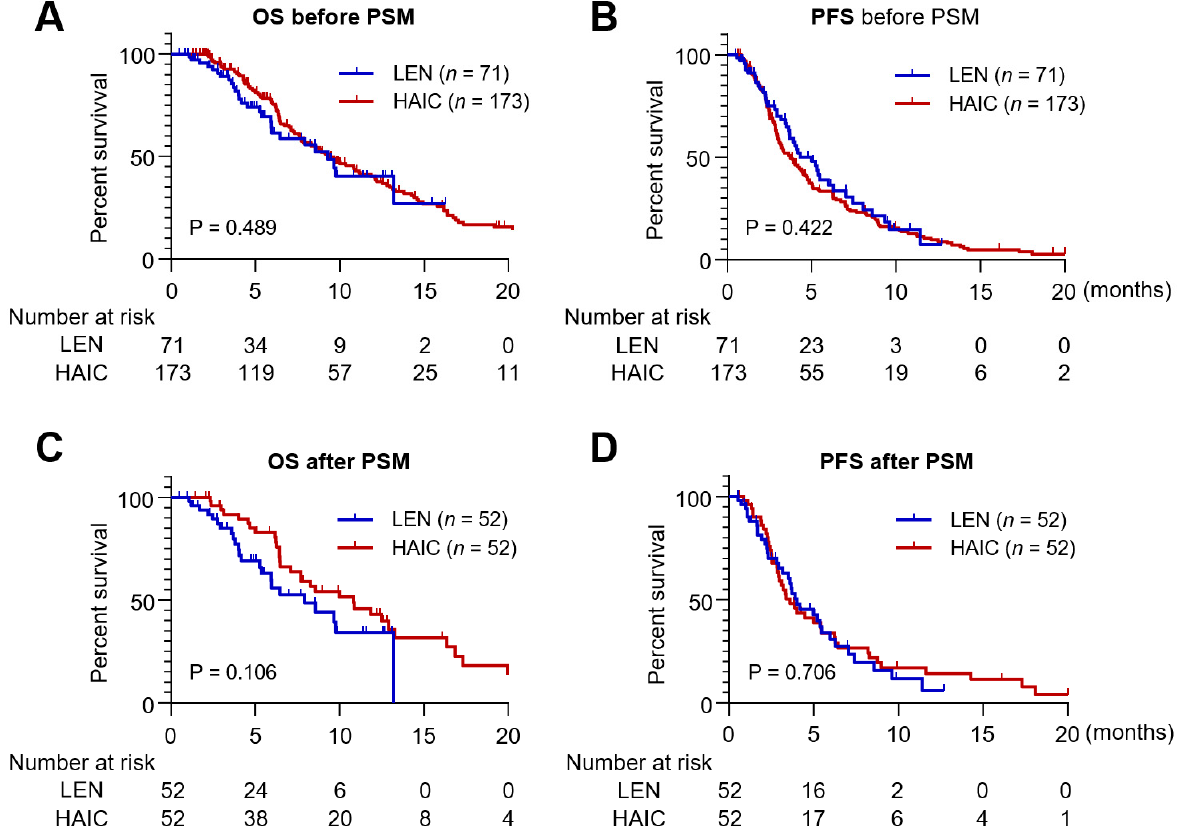
Figure 1. Kaplan–Meier survival curves analyzing OS and PFS in the HAIC and lenvatinib groups before ( n = 244) and after PSM ( n = 104). ( A ) Overall survival (OS) of patients treated with lenvatinib and HAIC in the entire cohort. ( B ) Progression free survival (PFS) of patients treated with lenvatinib and HAIC in the entire cohort. ( C ) OS of patients treated with lenvatinib and HAIC following propensity score matching (PSM). ( D ) PFS of patients treated with lenvatinib and HAIC following PSM. PSM: propensity score matching .